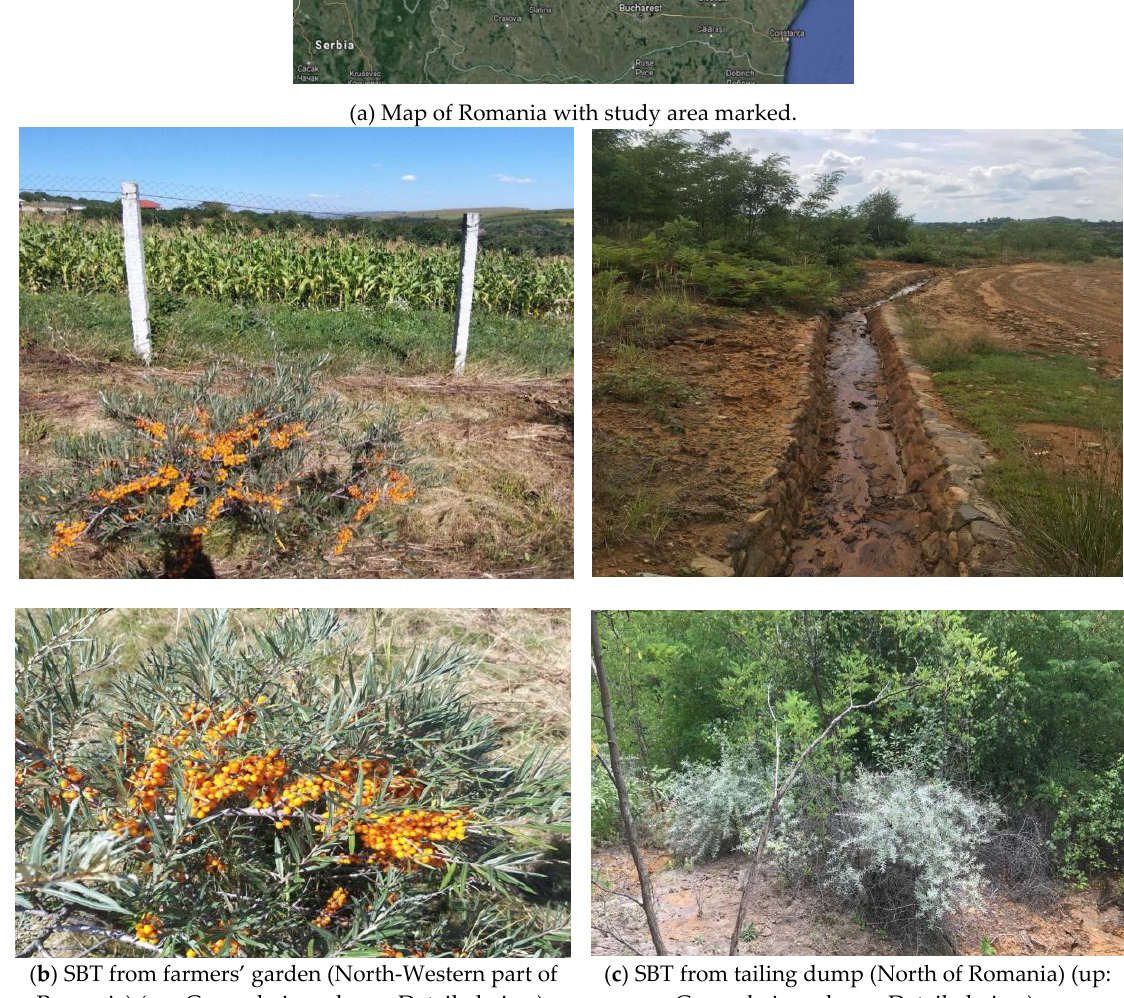
( c ) SBT from tailing dump (North of Romania) (up: General view; down: Detailed view). Figure 1. Study area and sample collection. Source: ( a ) Adapted from [50]; ( b , c ) photos from the authors’ archive. Legend: Represents the tailings dumps where samples 1 to 4 were sampled; the farmers’ garden location (for samples 5 and 6) is represented in the yellow circle; Indicates the location of the supermarket (sample 7).